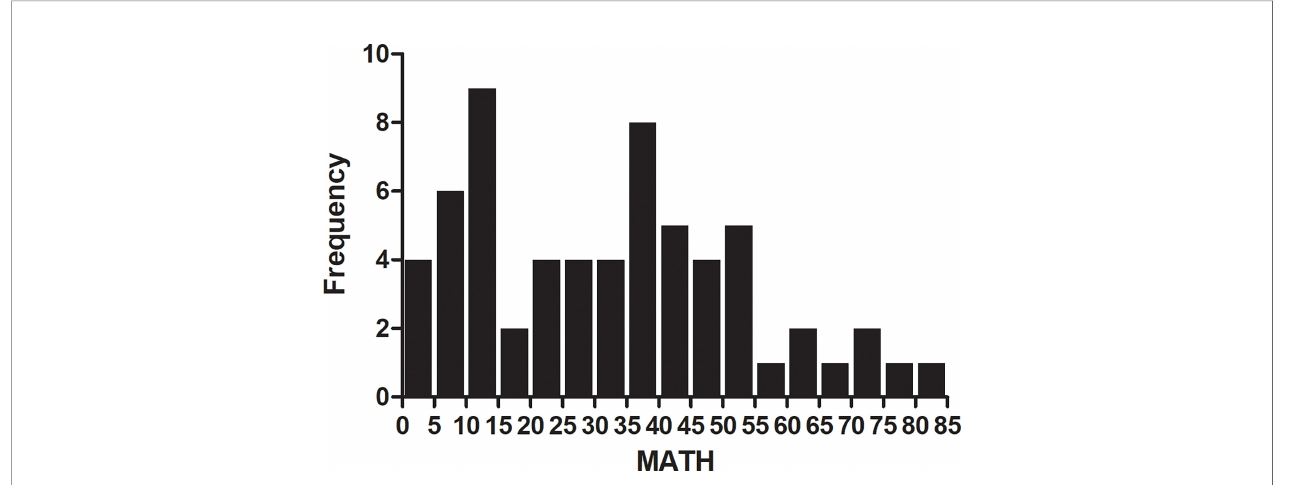
FIGURE 2 | Frequency of mutant-allele tumor heterogeneity (MATH) score among 63 patients with lung adenocarcinoma. Patients with MATH 10-15 and 35-40 account for 9% and 8% portion. The median value of MATH was